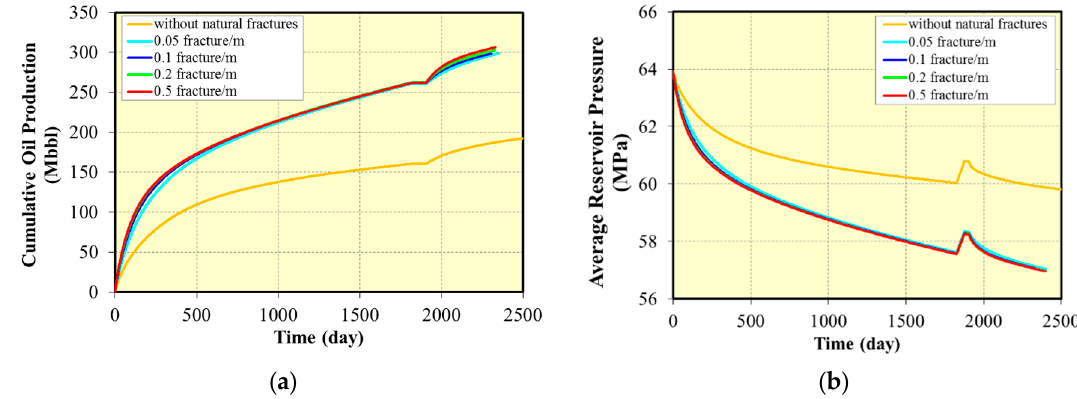
Figure 12. Numerical model with complex fractures: ( a ) without natural fractures; ( b ) 0.05 natural fracture/m; ( c ) 0.1 natural fracture/m; ( d ) 0.2 natural fracture/m; ( e ) 0.5 natural fracture/m. Blue line indicates the wellbore. Red and grey pieces represent hydraulic fractures and natural fractures respectively. Table 11. Summary of results for huff-n-puff with different natural fracture density.